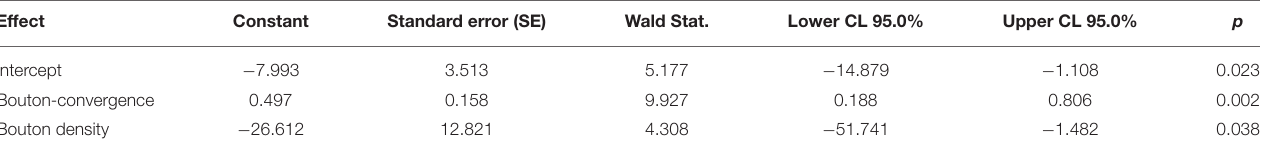
TABLE 11 | Parameter estimates (modeled probability that P /NP = NP) in the final model including variables that significantly improved the model fit.